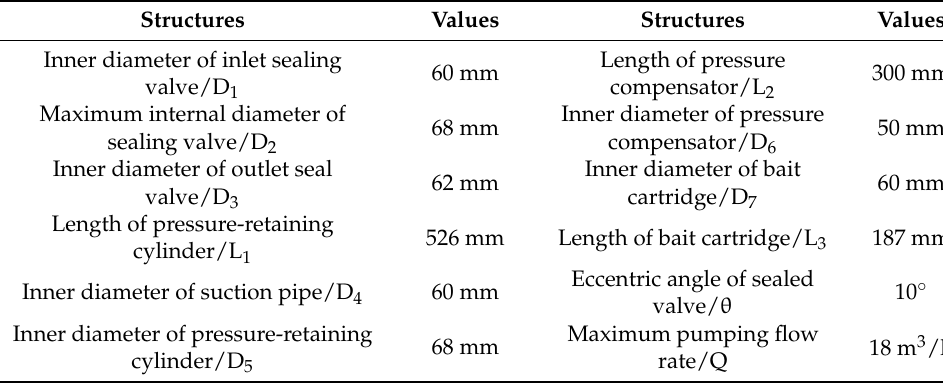
Figure 2. Structure diagram of pressure-retaining area. Table 1. Structural parameters of HSMPS.